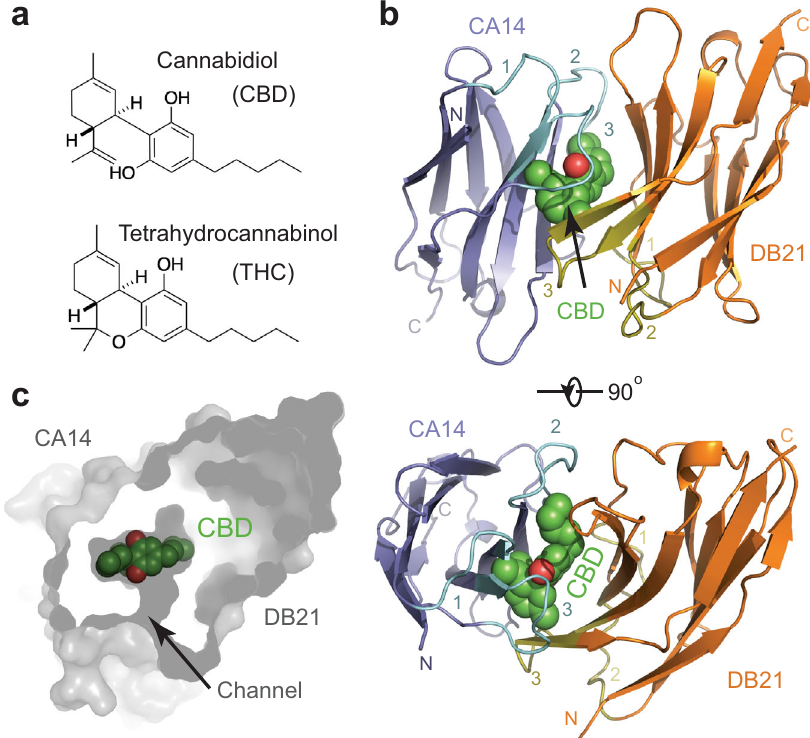
Fig. 1 Overall structure of a CBD-bound dual-nanobody sensor. a Chemical structures of cannabidiol (CBD) and tetrahydrocannabinol (THC). b Two orthogonal views of the crystal structure of the CA14-CBD-DB21 ternary complex. CBD is shown as green and red spheres. CA14 and DB21 are shown as cartoon diagrams and colored blue and orange, respectively. Three complementarity determining regions (CDRs) of CA14 and DB21 are highlighted in cyan and olive, respectively. CDR1, CDR2, and CDR3 are labeled as 1, 2, and 3. c Cross-section view of the CBD-binding pocket formed by the nanobody dimer. CBD, shown in green and red spheres, is located in the central pocket with a nearby channel too small for it to enter or